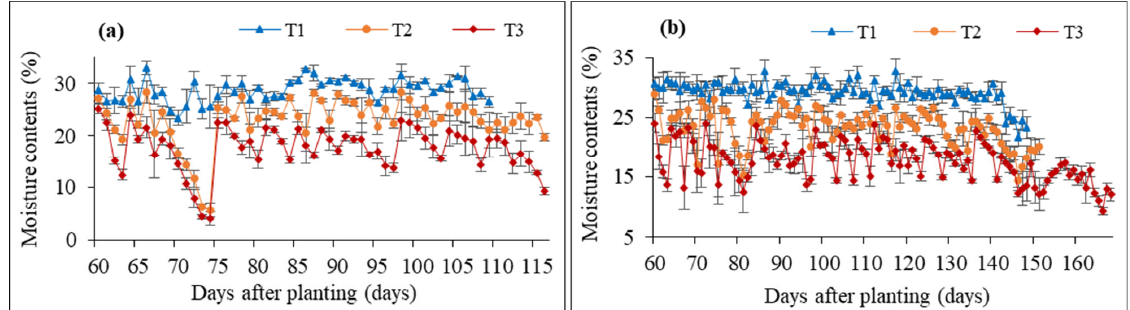
Figure 3. Soil moisture contents observed at 0–15 cm soil depth under applied treatments to genotypes in group A ( a ) and group B ( b ) in the yield assessment experiment (2). Vertical bars indicate ± standard errors for means of soil moisture contents observed from three replications. T1: control (100% FC), T2: moderate stress (70% FC), T3: severe stress (50% FC).